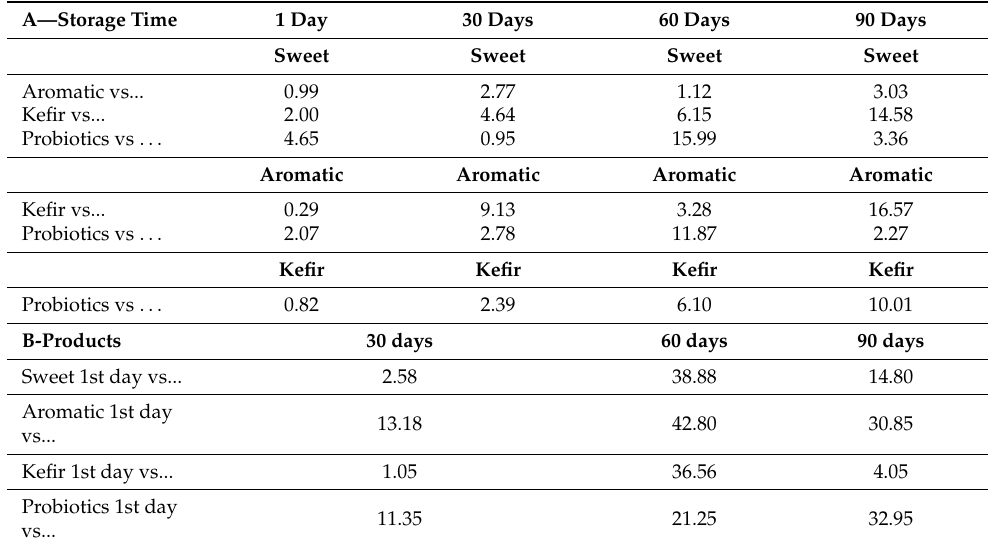
Table 3. Color differences ∆ Eab* among products and over storage. (A) ∆ Eab* between butter samples at each day of storage, 1, 30, 60 and 90. (B) ∆ Eab* for the same butter between the first day of storage and days 30, 60 and 90 (vs. = versus).